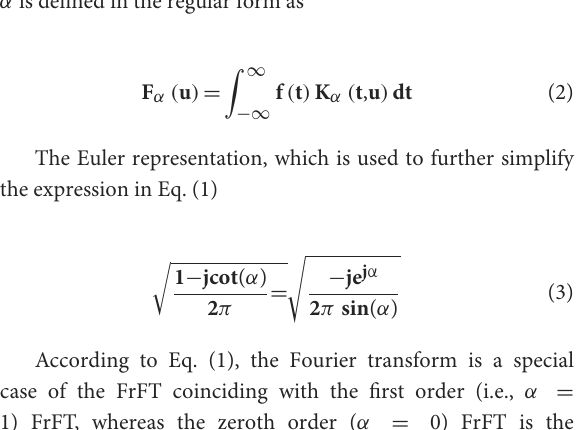
Figure 1 is a visual representation of the FrFT’s functioning.